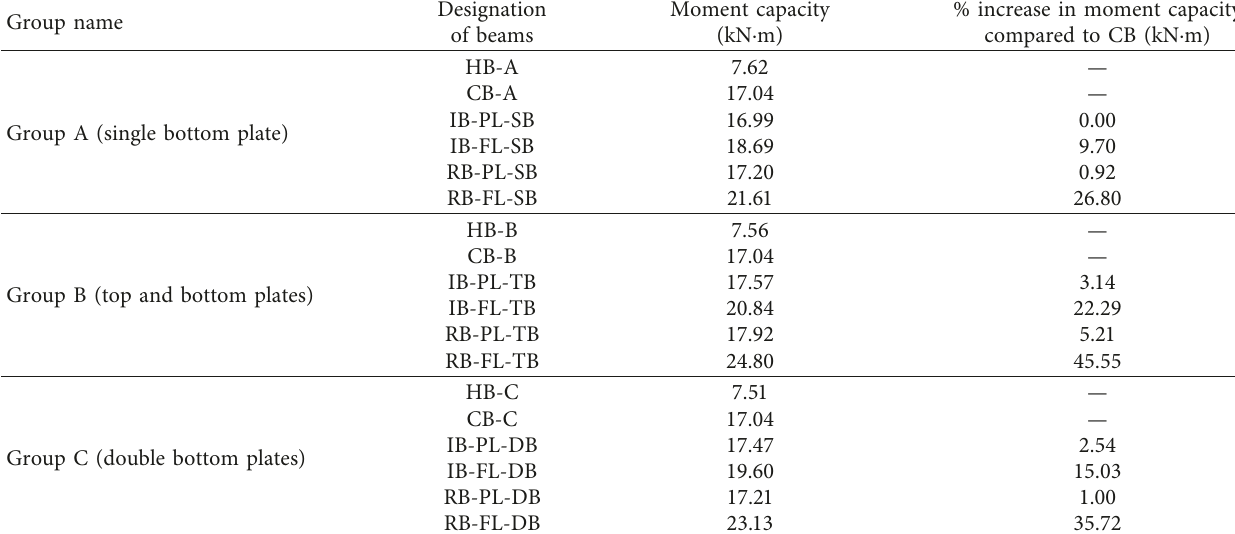
Table 7: Ultimate moments and percentage of increase in moment